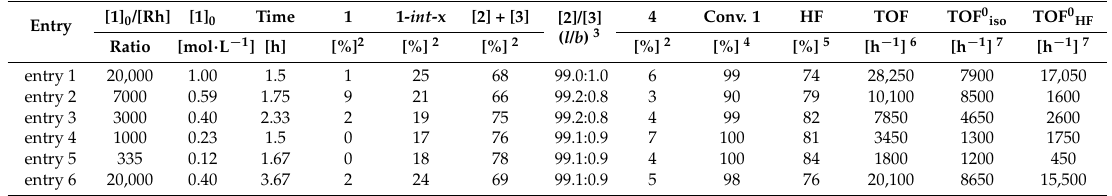
Table 1. Influence of the [ 1 ] 0 /[Rh] ratio on tandem isomerization-hydroformylation of 10-undecenitrile 1 .